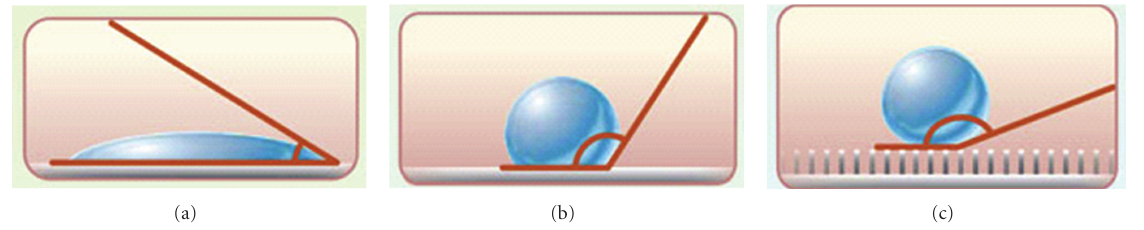
Figure 8: (a) Hydrophilic surface: angle less than 30 degrees; (b) Hydrophobic surface: angle greater than 90 degrees; (c) Superhydrophobic surface: angle greater than 150 degrees.